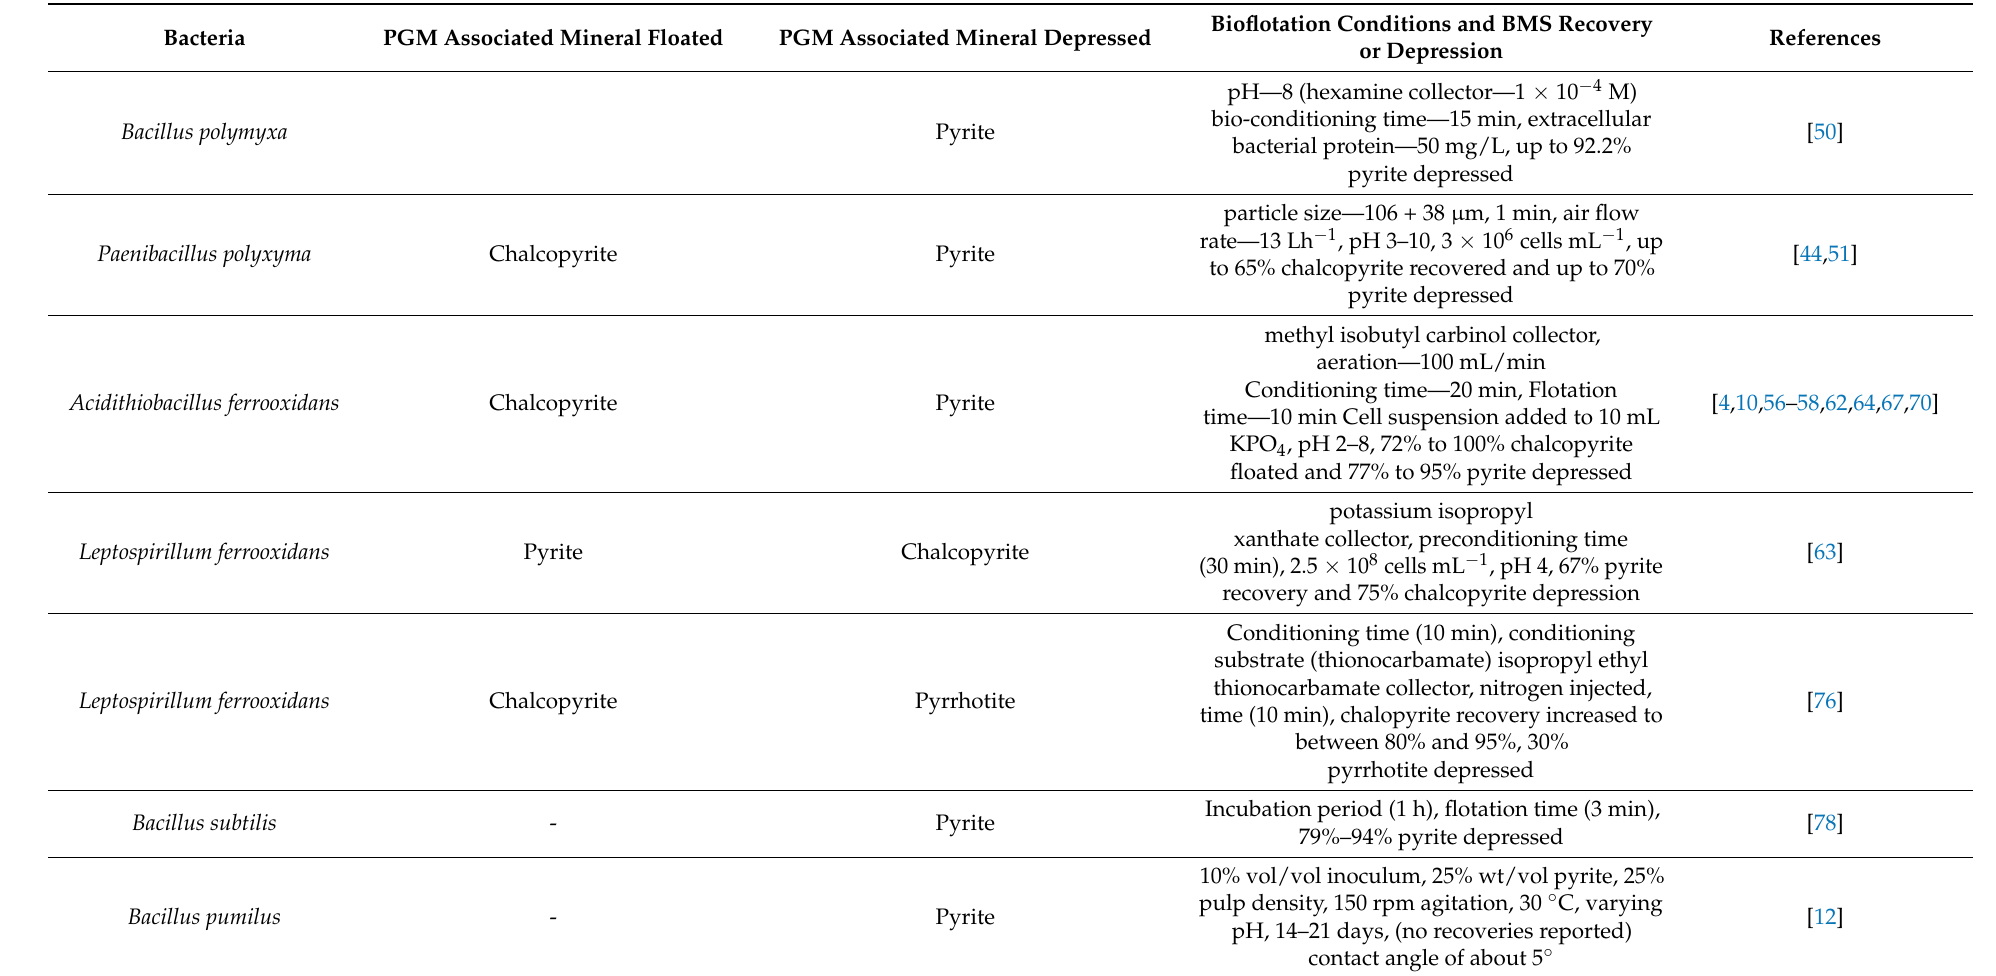
Table 5. Bacteria involved in the flotation of PGM associated minerals and the corresponding